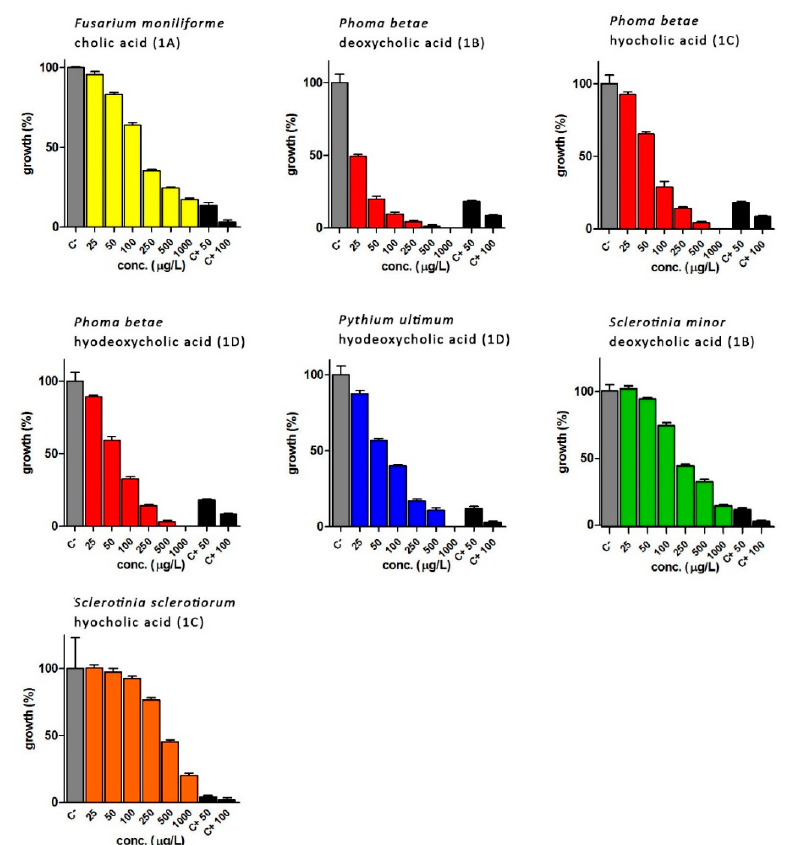
Figure 3. Growth inhibition of phytopathogenic fungi treated with bile acids ( 1a,d ). FM = Fusarium moniliforme ; PB = Phoma betae ; PU = Pythium ultimum ; SM = Sclerotinia minor ; SS = Sclerotinia sclerotiorum . C − = DMSO; C+ 50 = fluconazole 50 µ g/mL; C+ 100 = fluconazole 100 µ g/mL. 1a = cholic acid, 1b = deoxycholic acid, 1c = hyocholic acid, 1d = hyodeoxycholic acid.